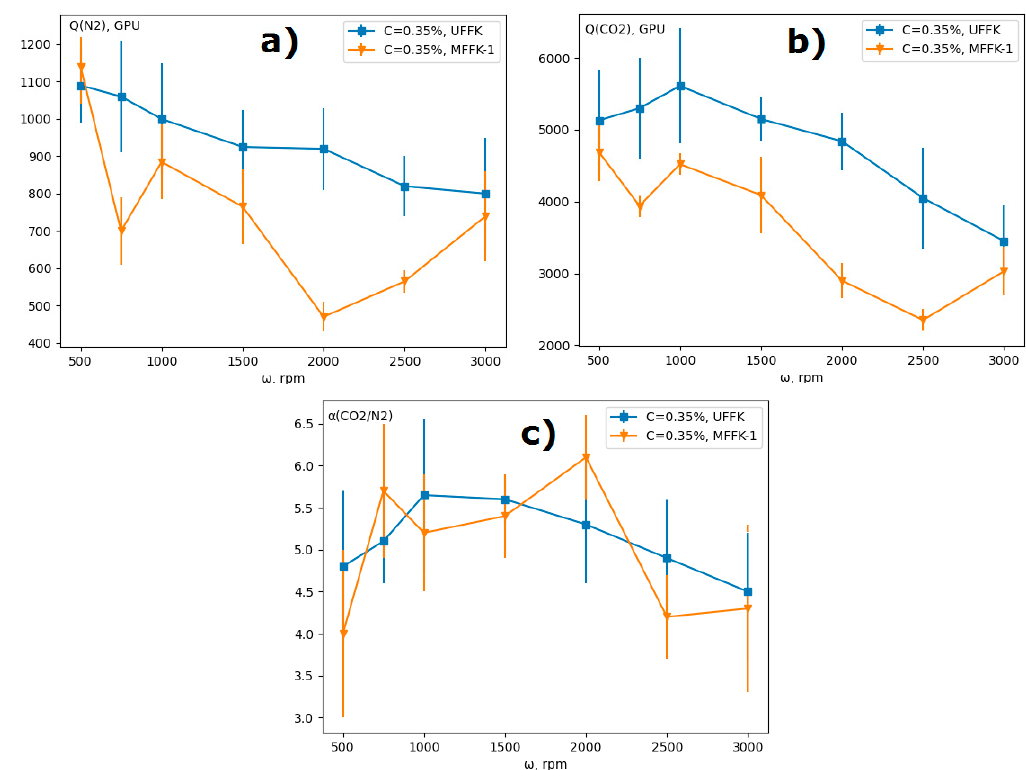
Figure 5. Gas transport properties of composite membranes obtained by applying PTMSP solution (C = 0.35 wt %) on MFFK-1 and UFFK supports at different spin coater rotation speeds: ( a ) N 2 permeance; ( b ) CO 2 permeance; ( c ) ideal CO 2 /N 2 selectivity. Table 5. Estimated by EDX PTMSP penetration depth into the pores of the support (l sup ) for compo-